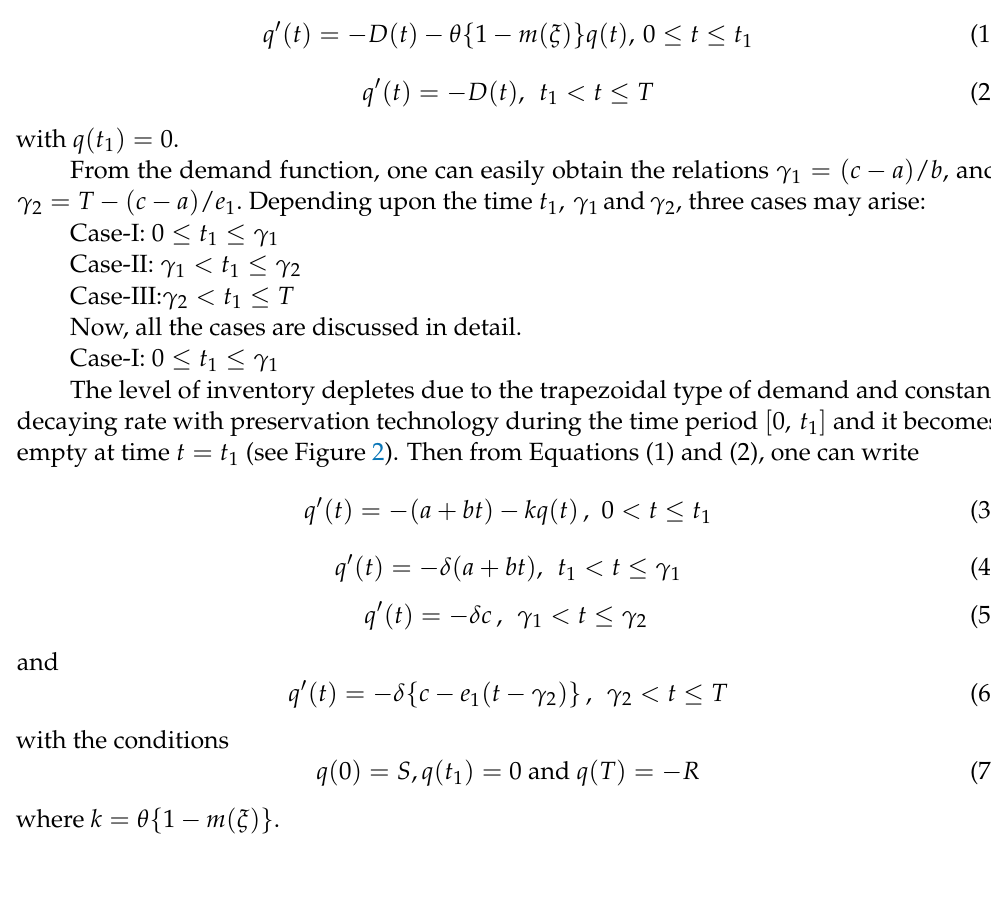
Figure 1. Pictorial representation of trapezoidal demand pattern function of the demand rate.